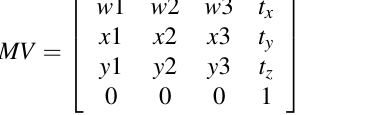
Listing 1. Example of a generated log file 91.4096 -216.137 178.876 -0.1097 0.7909 -0.6019